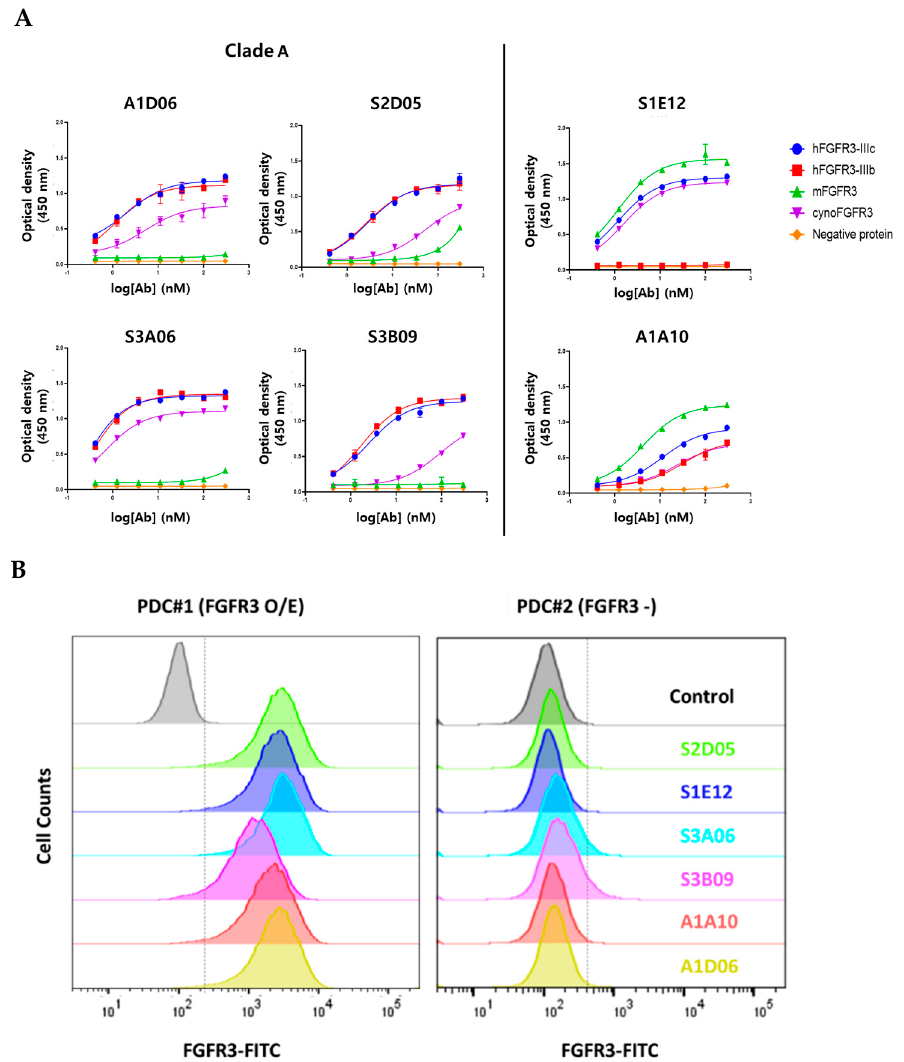
Figure 5. Binding characterization analysis of anti-FGFR3 antibody derived following the introduction of semi-automated bio-panning. ( A ) The binding specificity of selected FGFR3 antibodies to FGFR3 isoforms and interspecies was evaluated using ELISA. ( B ) The binding ability of FGFR3 antibodies to FGFR3-overexpressing cells (PDC#1) and FGFR3 negative cells (PDC#2) was determined using flow cytometry. Table 3. Binding affinities (KD) of selected clones to human FGFR3 isotypes and interspecies FGFR3.